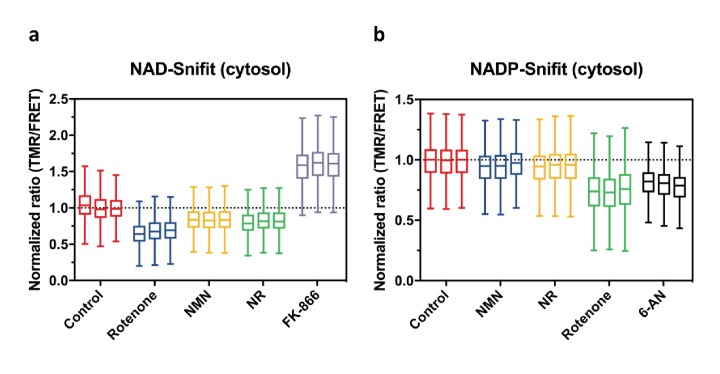
Effects of drugs and NAD biosynthetic precursors on NAD+ and NADPH/NADP+ levels.FRET ratios (TMR/FRET) as measured by flow cytometry of cytosolic NAD-Snifit (a) and cytosolic NADP-Snifit (b) in U2OS cells after incubation of cells under the conditions specified. For each condition, data from three independent experiments are shown to demonstrate the reproducibility of these measurements. Measured FRET ratios (TMR/FRET) are normalized to untreated control. Abbreviations and conditions: 10 μM Rotenone, 1 mM nicotinamide mononucleotide (NMN), 1 mM nicotinamide riboside (NR), 100 nM FK866, 1 mM 6-aminonicotinamide (6-AN). The Tukey-style box plots represent the 25th and 75th percentiles at the lower and upper box limits and the median as the middle bar. The whiskers extend to ± 1.5 × IQR beyond the limits of the boxes, respectively. The position of the mean is indicated by a solid square. Each data set represent n = 2000–7000 events.10.7554/eLife.32638.015Figure 4—source data 1.